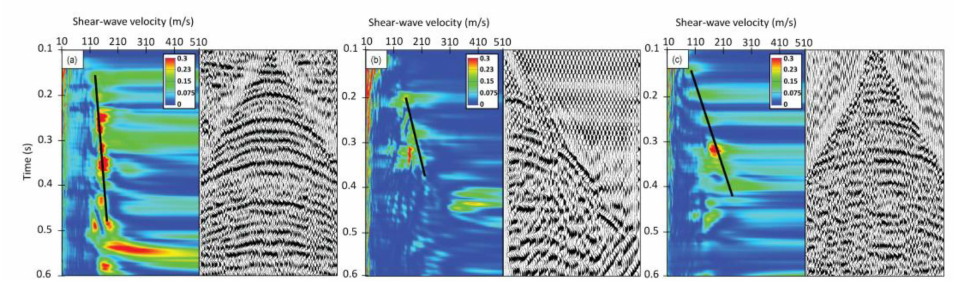
Figure 8. Semblance analysis of shear-wave seismic data during low ( a ), middle ( b ), and high ( c ) stages. The middle-stage analysis uses a PWA survey and the low and high stages use a CMP data set. The solid lines represent trends with the highest semblance points. On the right of the semblance plot is the seismic reflection sorted by CMP.